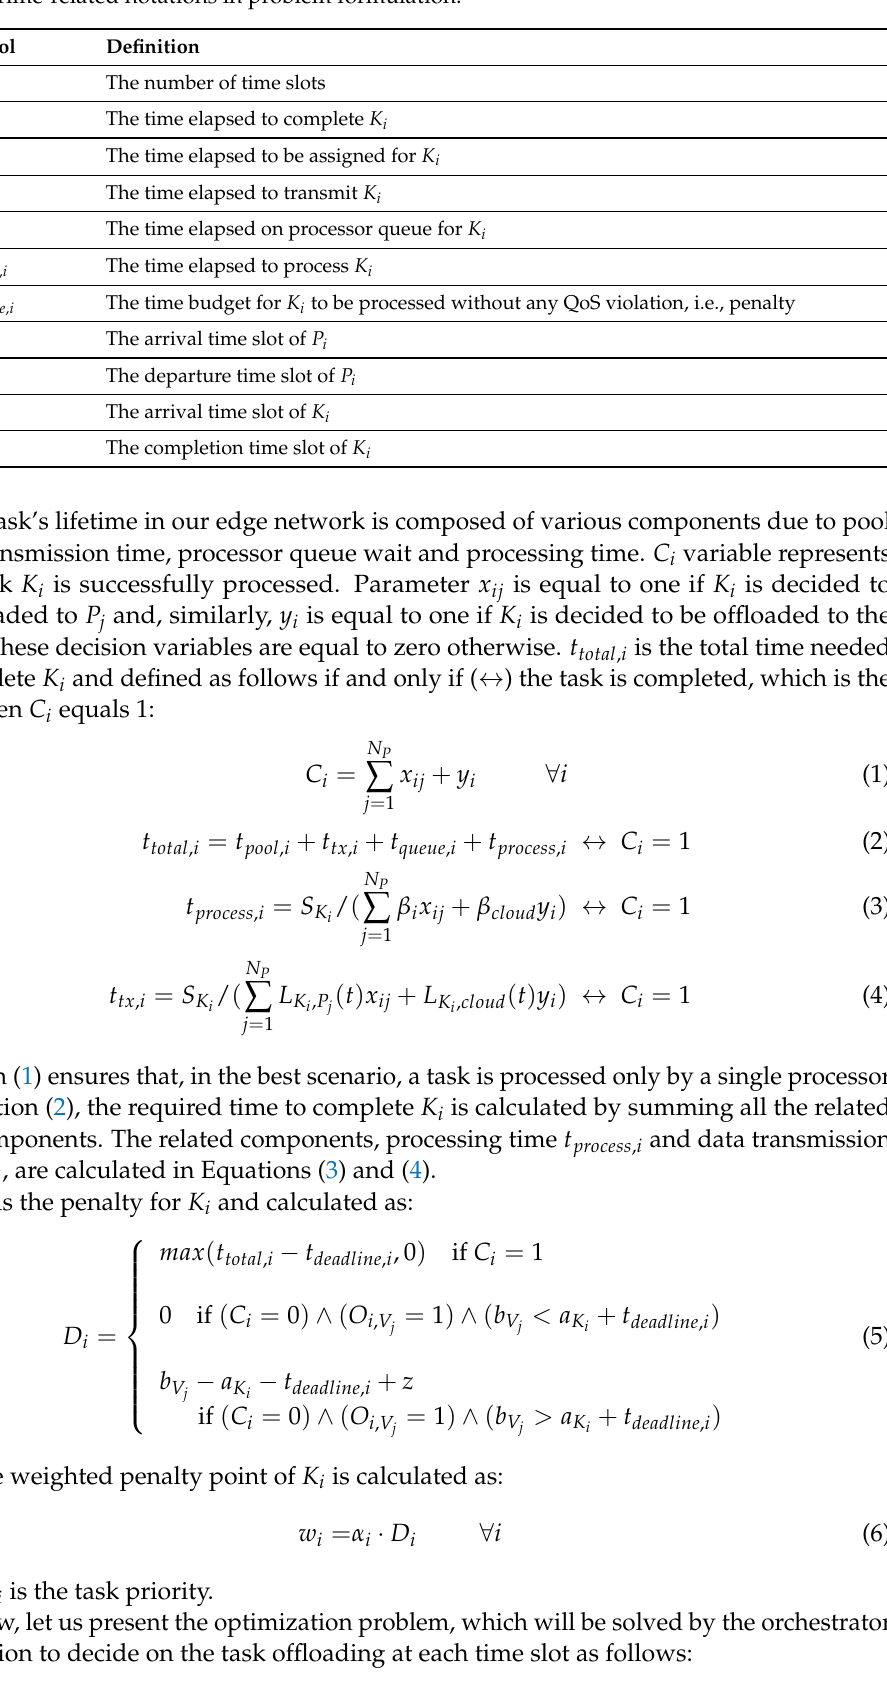
Table 2. Time-related notations in problem